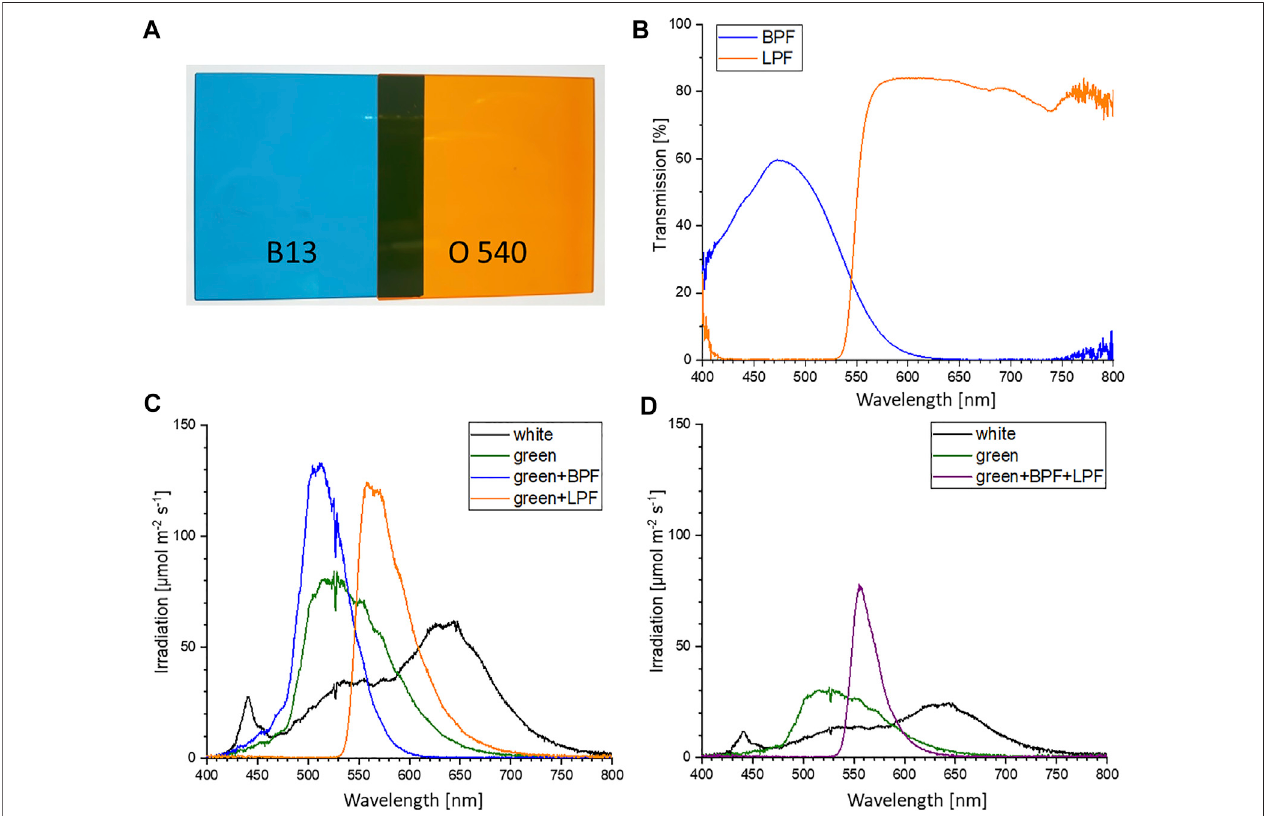
FIGURE2|(A) Coloredglass fi lters:band-pass fi lterB13(BPF)andlong-pass fi lterO540(LPF) (LaserComponents2022) (B) TransmissionvaluesoftheBPFand LPF. Values obtained via warm-white light emitting diode (LED) illumination and ocean optic spectrometer measurements. (C) Irradiation intensities of warm-white LED (SWW),greenLED(510 nm),greenLEDwithBPFandgreenLEDwithLPFatsetpoint200 μ mol m − 2 s − 1 . (D) Irradiationintensitiesofwarm-whiteLED(SWW),greenLED (510 nm) with BPF and LPF were set to 75 μ mol m − 2 s − 1